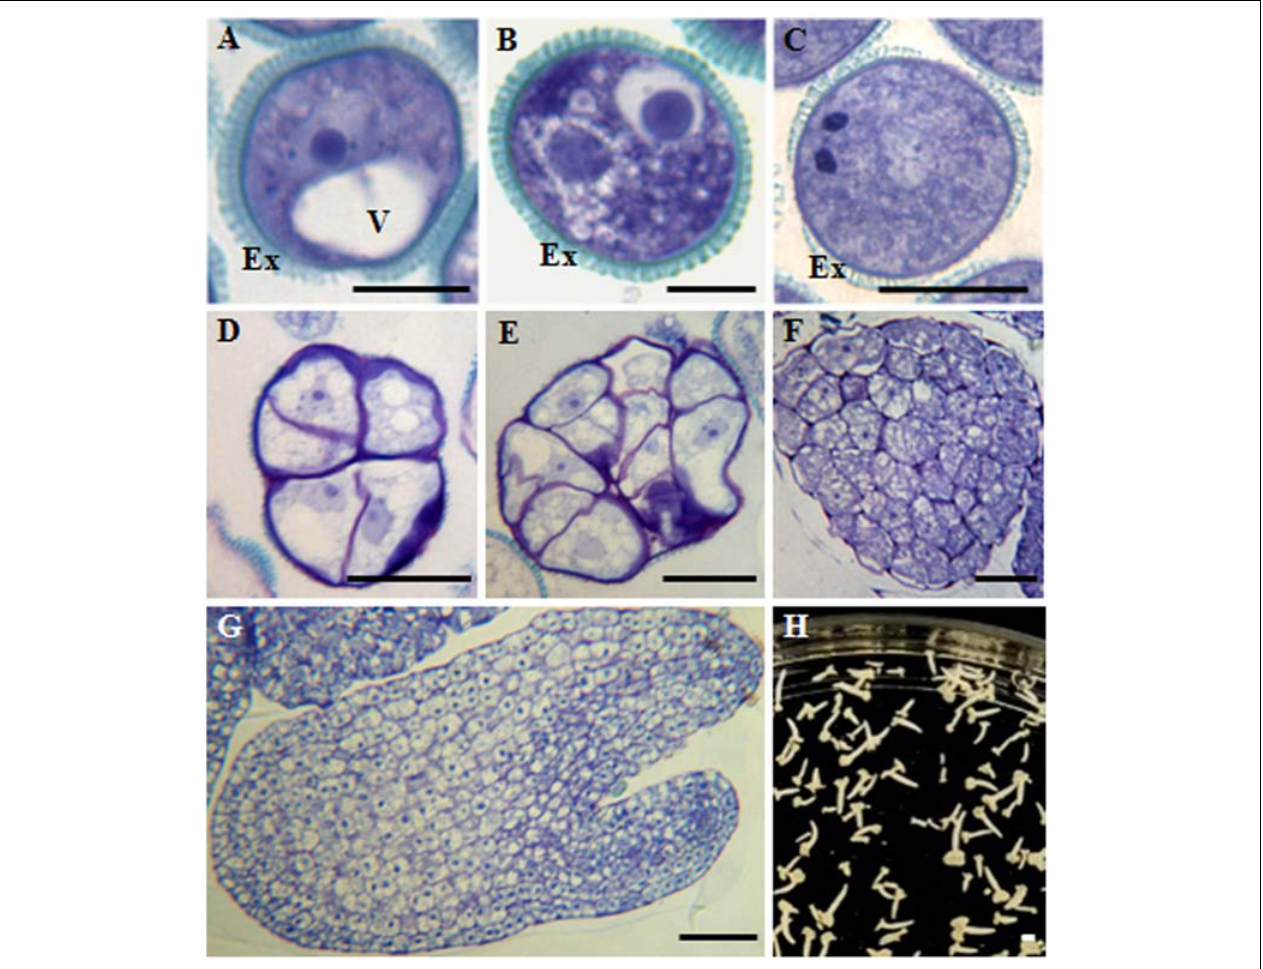
FIGURE 1 | Main stages of pollen development and microspore embryogenesis of Brassica napus . Micrographs of semithin sections stained by Toluidine blue showing the cellular organization. (A) Vacuolated microspore. (B,C) Gametophytic development. (B) Bicellular pollen grain. (C) Tricellular pollen grain. (D–H) Microspore embryogenesis. (D,E) Proembryos. (F) Globular embryo. (G) Torpedo embryo. (H) Cotyledonary embryos, panoramic view of a Petri dish of a microspore embryogenesis culture after 30 days. Ex, exine; V, vacuole. Bars represent: (A–C) : 10 µ m, (D–F) : 20 µ m, (G) : 50 µ m, (H) : 1